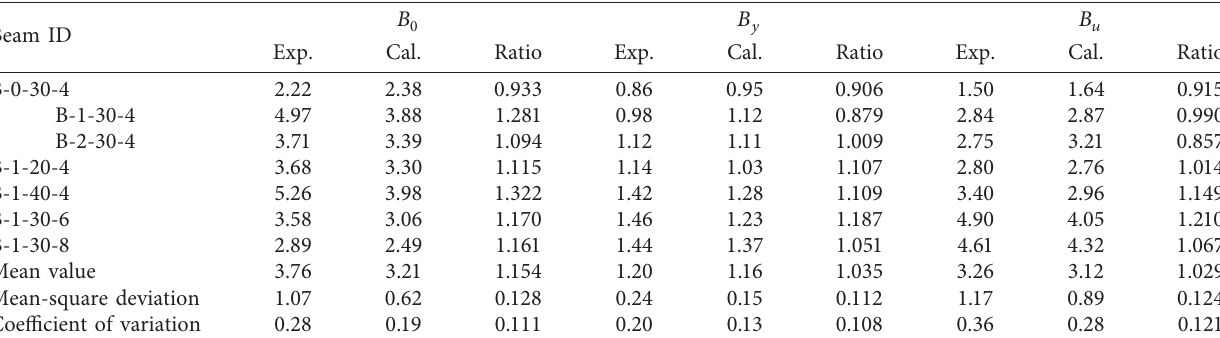
Table 7: Experimental and calculated values of cracking stiffness, yield stiffness, and ultimate stiffness of